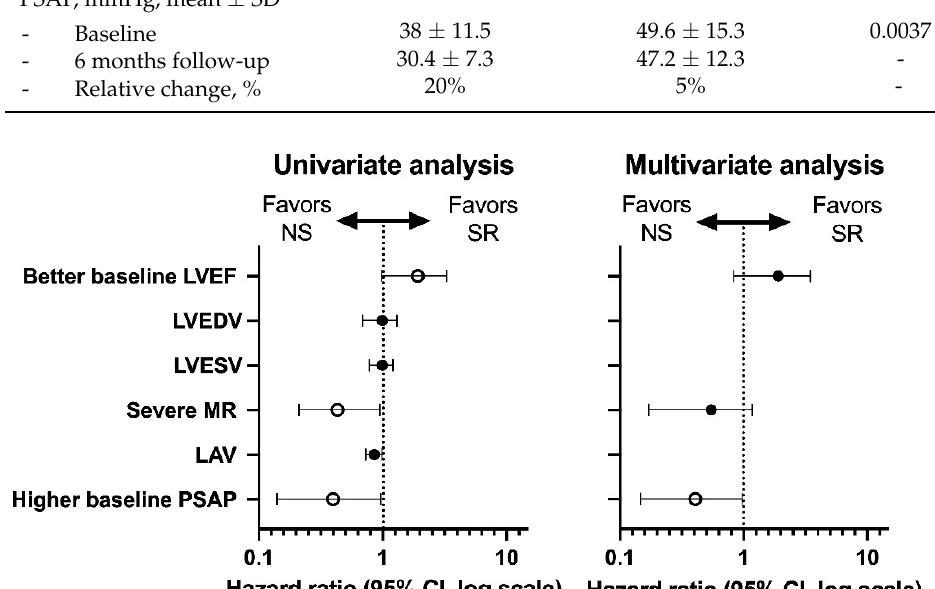
Figure 2. Univariate and multivariate analysis of the echocardiographic parameters. The empty circles represent the statistically significant difference.